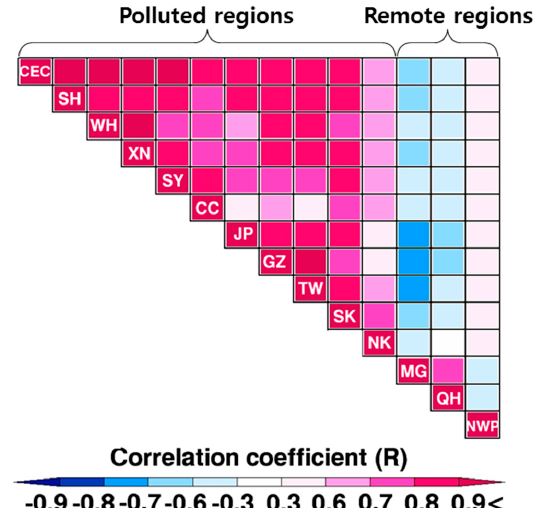
linear trend line. Atmosphere 2019 , 10 , x FOR PEER REVIEW